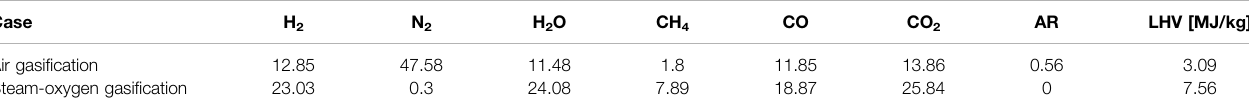
TABLE 5 | Biosyngas composition (mol%) from the model calculations of air and steam-oxygen gasi fi cation